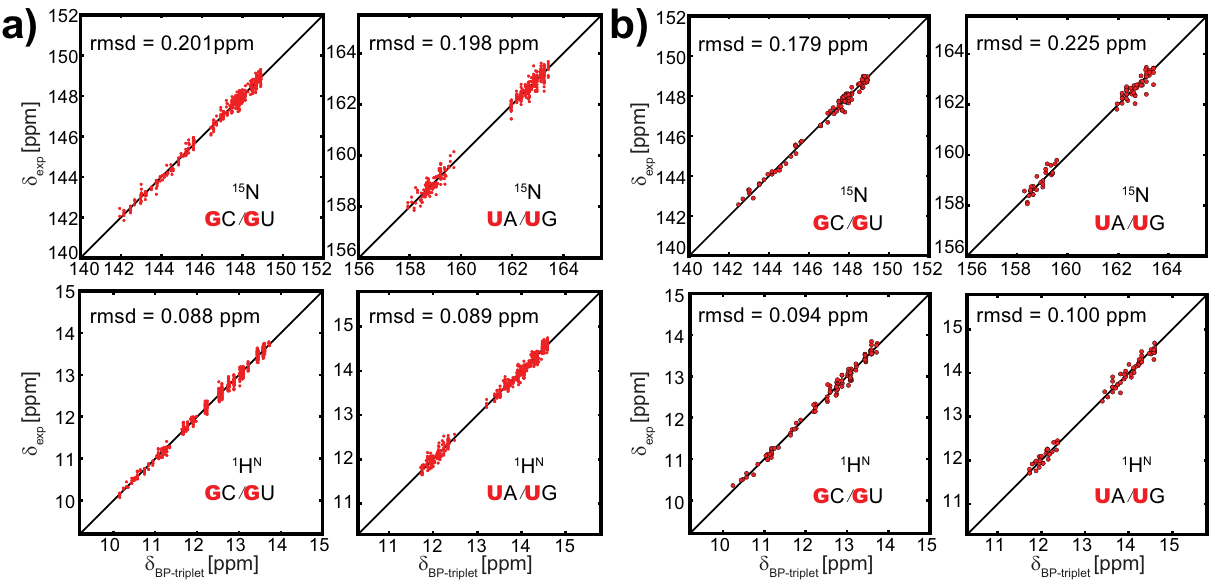
Fig. 4 The reconstructed imino chemical shifts using the decomposed shifts. a Correlation between reconstructed and experimental 15 N (upper panel) and 1 H N (lower panel) chemical shifts for BP-triplets centered with GC/GU (left) and UA/UG (right) in the training dataset. b Correlation between reconstructed and experimental 15 N (upper panel) and 1 H N (lower panel) chemical shifts for BP-triplets centered with GC/GU (left) and UA/UG (right) in the testing dataset.